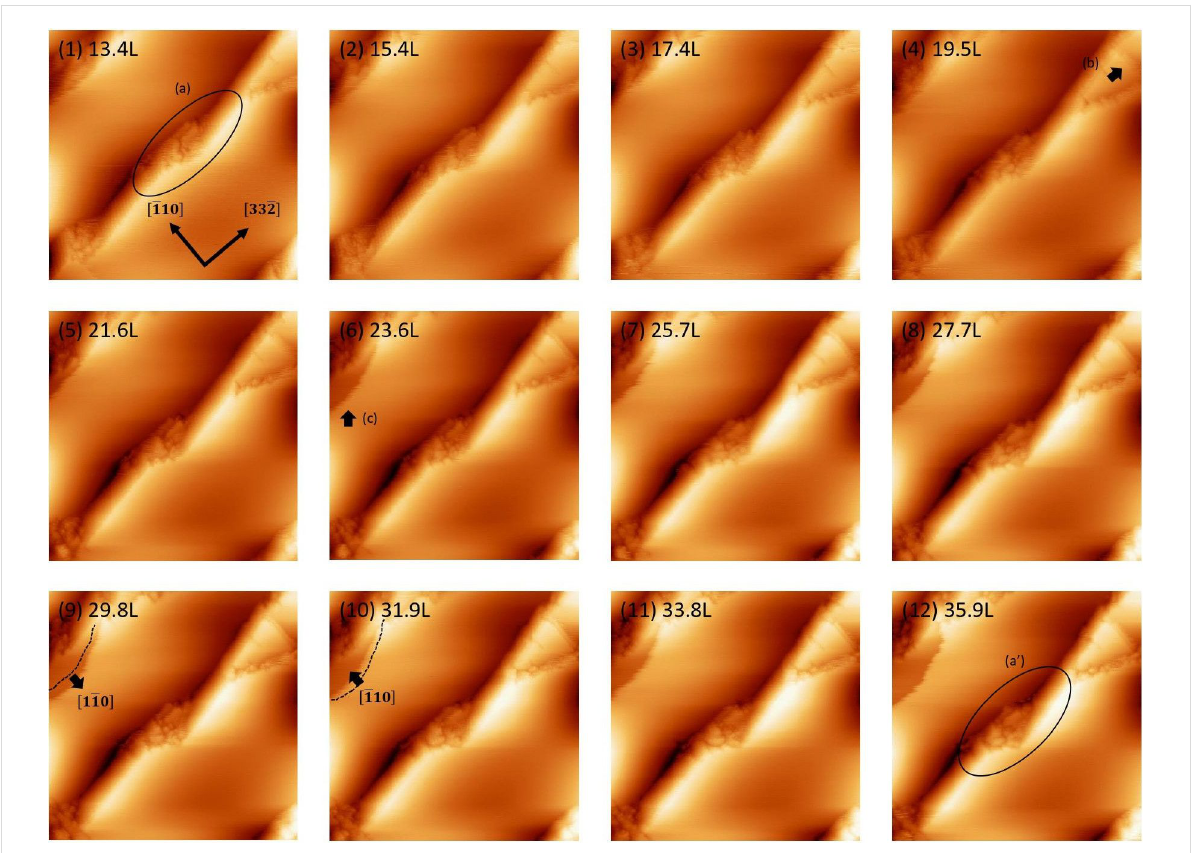
Figure 5: A series of filled-state STM images of Si(113)-(3 × 2) upon oxidation at an oxygen pressure of 6.5 × 10 − 7 Pa and a sample temperature of 820 K. A Langmuir unit is defined such that 1.0 L = 1.33 × 10 − 4 Pa·s. Image size: 100 × 100 nm 2 , V s = − 2.0 V, I t = 0.07 nA.